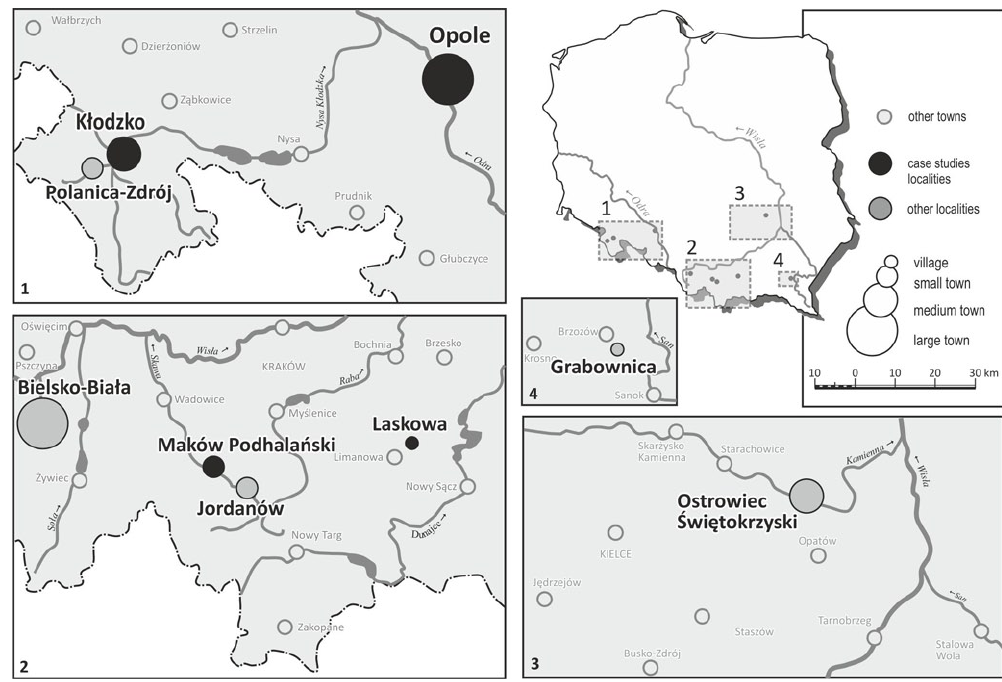
Fig. 1. Localities in southern Poland included in the study. Source: spatial data from Biernacki et al.